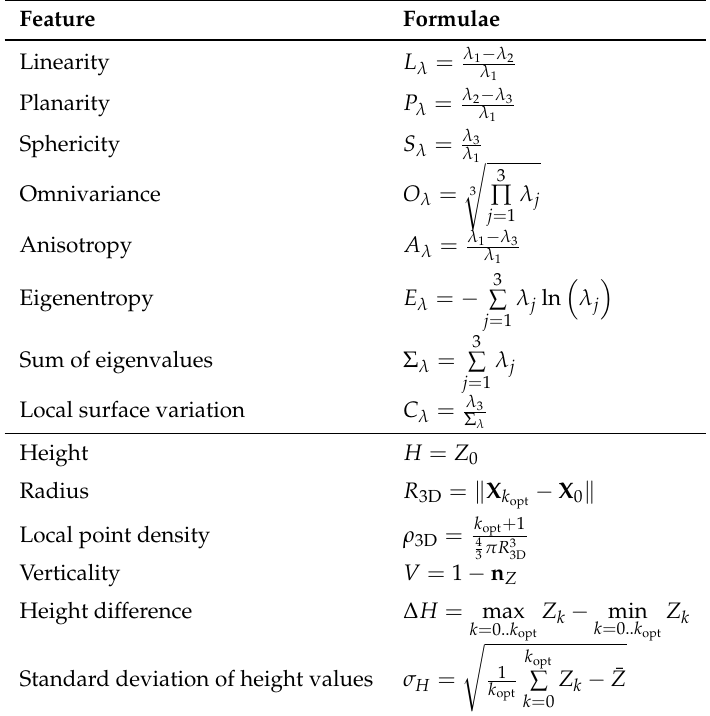
Table 1. The involved local 3D shape features (upper part) and the involved geometric 3D properties (lower